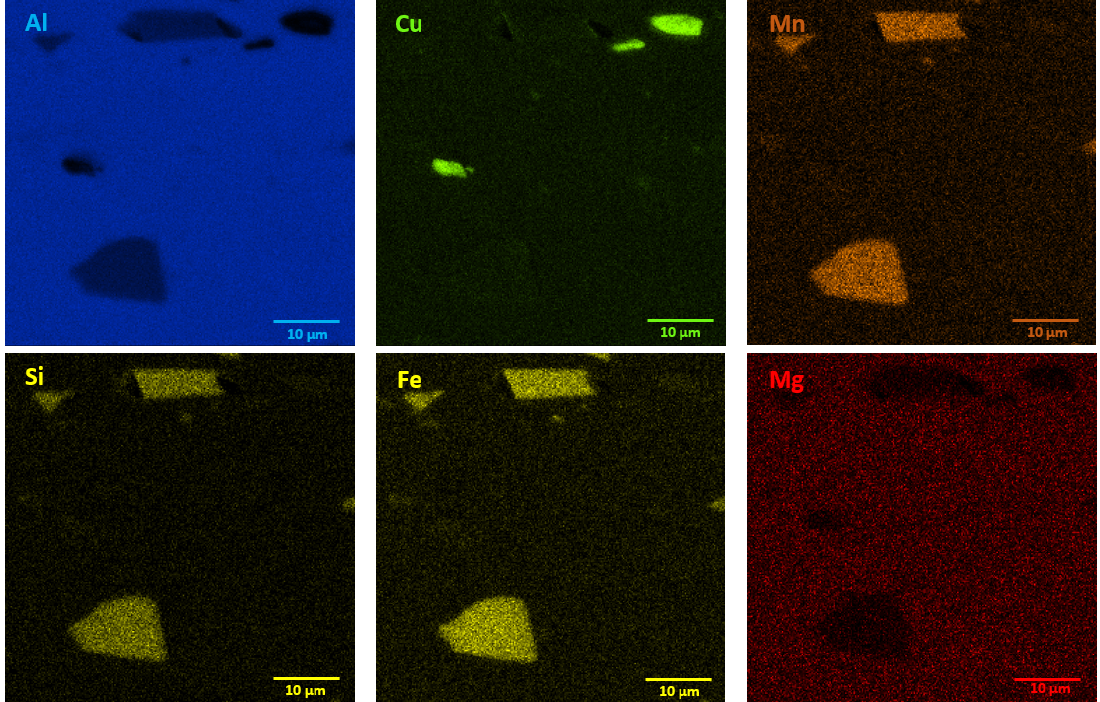
Figure 4. EDS mapping showing precipitates in clad AW-2024-T3 alloy in the initial state.